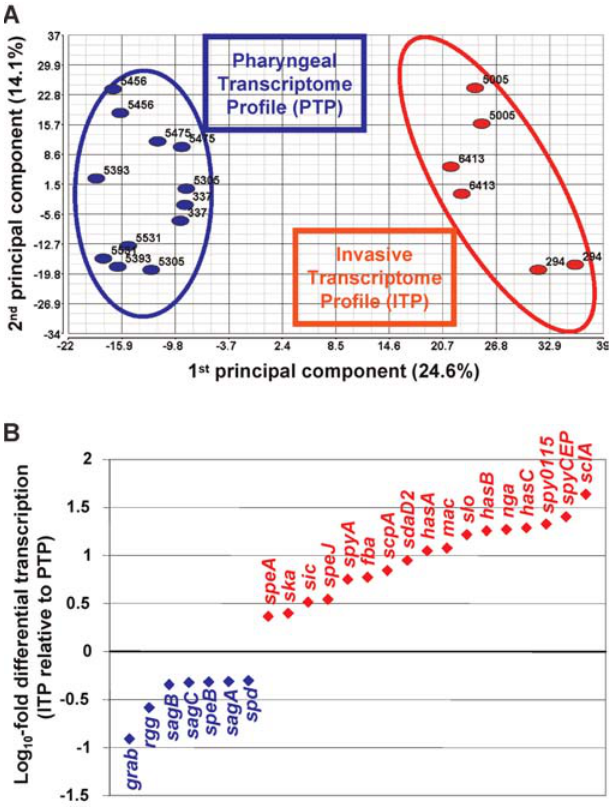
Figure 1. Differential Gene Expression of ITP and PTP GAS (A) Principal component analysis plot showing transcriptome differences between invasive (red) and pharyngeal (blue) isolates. Principal compo- nent analysis assesses the variance in a dataset in terms of principal components. The two most significant principal components are displayed on the x- and y-axes. Ellipses (calculated using 2X standard deviation for each gene per group) have been superimposed to highlight group differences between ITP and PTP strains. Numbered data points referto theMGAS strain numberfrom which theRNA samplewas isolated. The percentages of the total variation that are accounted for by the 1st and 2nd principal components are shown on the x- and y-axes labels. (B) Log 10 -fold transcript differences between the three ITP and six PTP isolates shown in (A) for select virulence genes and virulence gene regulators. Genes that are expressed higher in ITP isolates are shown in red; those expressed higher in PTP isolates are shown in blue. All genes shown are statistically significant ( t -test followed by a false discovery rate correction, Q ,